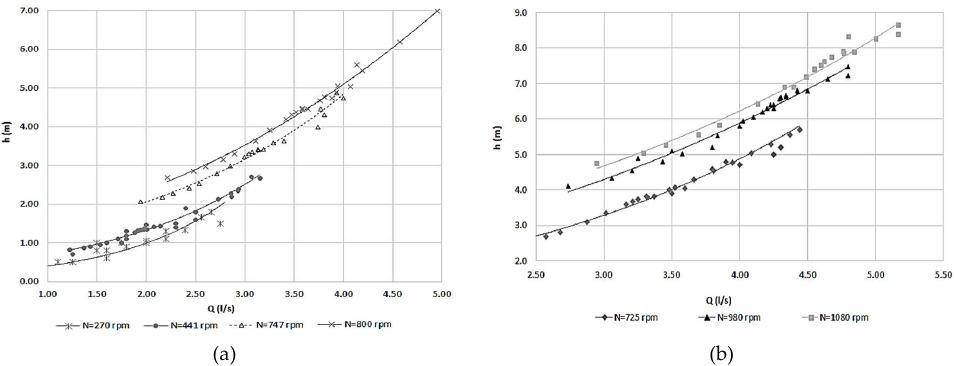
Figure 4. Identification of experimental characteristic curves: ( a ) PATs working in parallel mode (with 270 rpm ≤ PAT1 ≤ 441 rpm and 747 rpm ≤ PAT2 ≤ 800 rpm); ( b ) one PAT working in single mode (725 rpm ≤ PAT ≤ 1080 rpm).